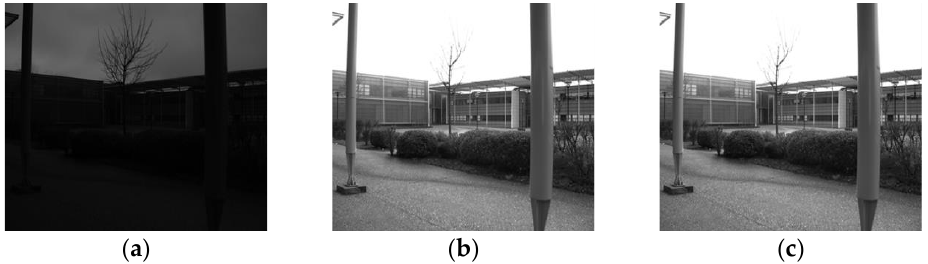
Figure 2. Ability of LIP subtraction of a constant to simulate exposure time changing. ( a ) Image f , “Laboratory” acquired with exposure time = 10 ms; ( b ) Image g , “Laboratory” acquired with expo- sure time = 100 ms; ( c ) Starting from f , simulation of an exposure time of 100 ms.